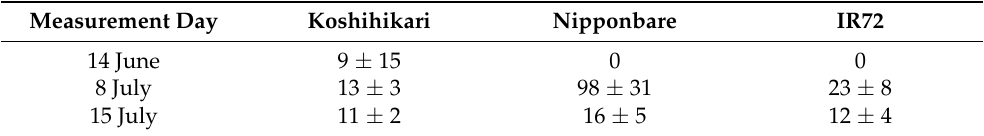
Figure 2. Time course of the emission rate of linalool from Koshihikari ( a ), Nipponbare ( b ), and IR72 ( c ) under constant temperature and light intensity during the light period and under constant temperature during the dark period. Black arrow indicates the time when the aboveground parts of the rice plant were enclosed in the bag. White arrow indicates the time when the bag was removed and then applied again to the above-ground parts. Table 2. Average emission rate of linalool during the light period on the second